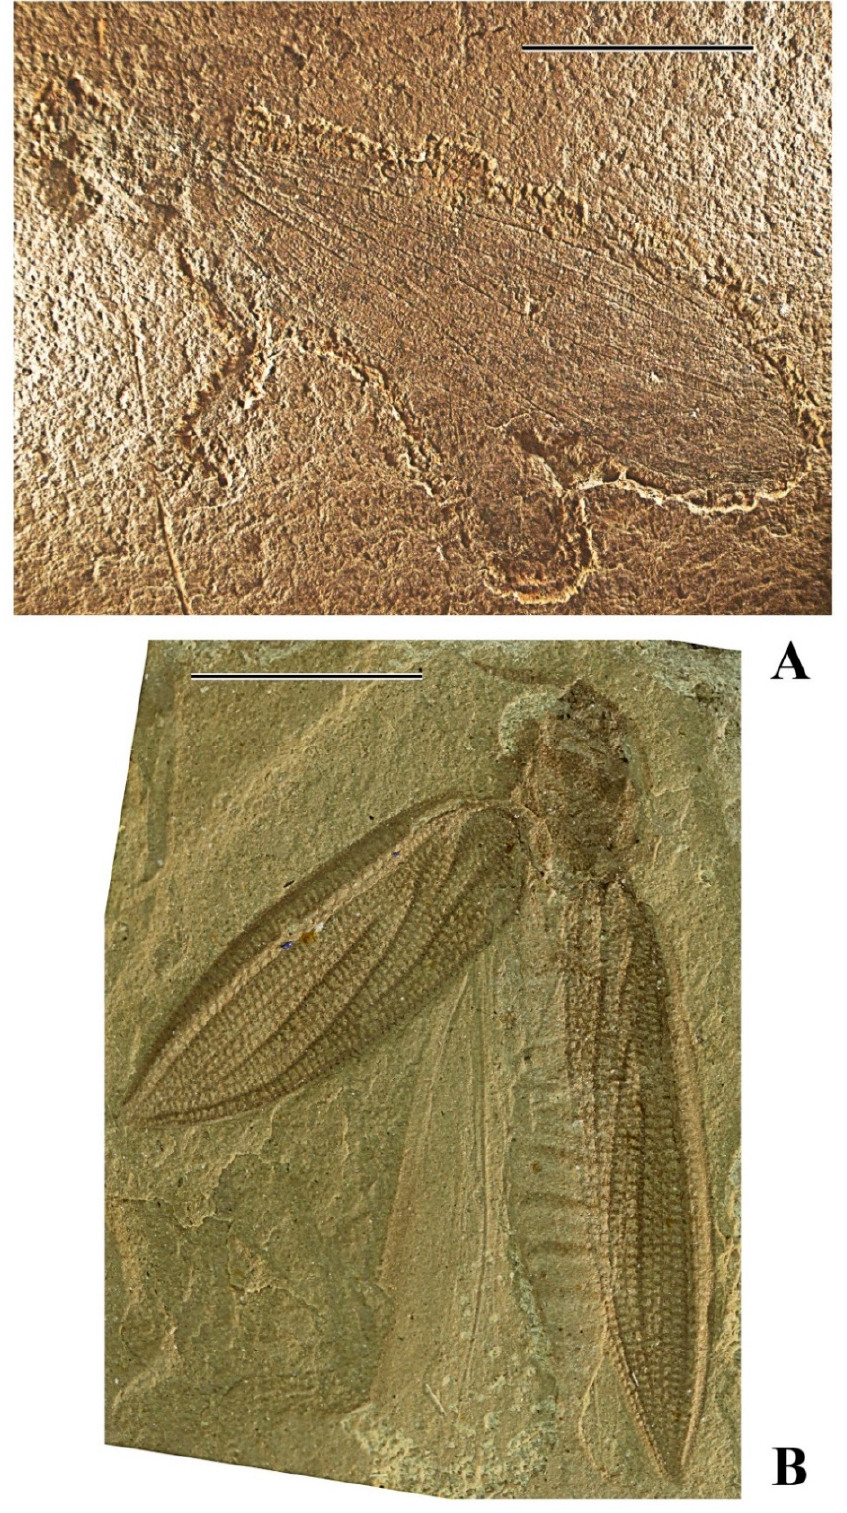
Figure 1. Stephanastidae (Skleroptera) and Tshekardocoleidae (Coleoptera): A — Stephanastus polinae , holotype MNHN.A.49011 (Carboniferous: Gzhelian; Commentry, Allier), length of print 28.0 mm, scale bar = 8.0 mm; after Kirejtshuk & Nel [19] with changes. B — Moravocoleus permianus , holotype PrF UK: 1 / 1968 (Permian: Cisuralian, Sakmarian; Moravia, Obora), length of print 7.9 mm, scale bar = 2.4 mm; from http: // www.zin.ru / Animalia / Coleoptera / rus /